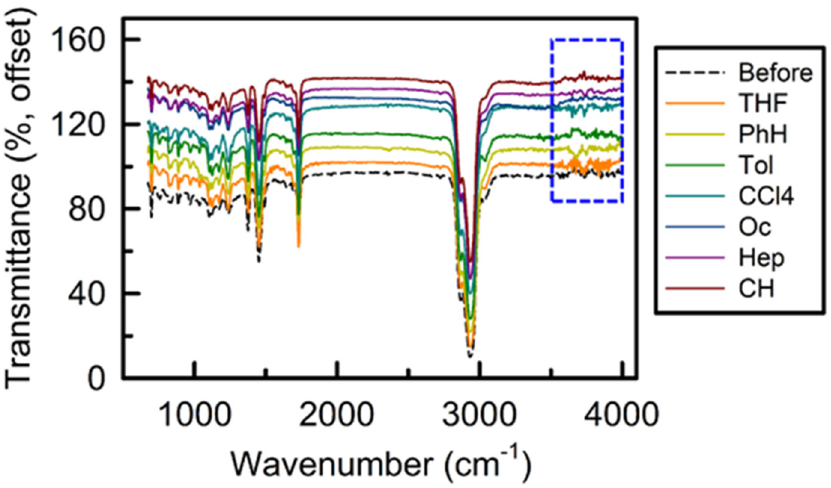
Figure 9. FTIR spectra of adhesive before and after different solvent dissolution and